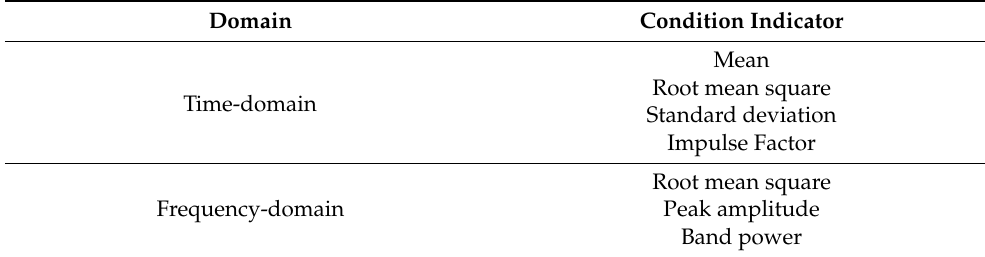
Table 3. Some examples of frequently used condition indicators